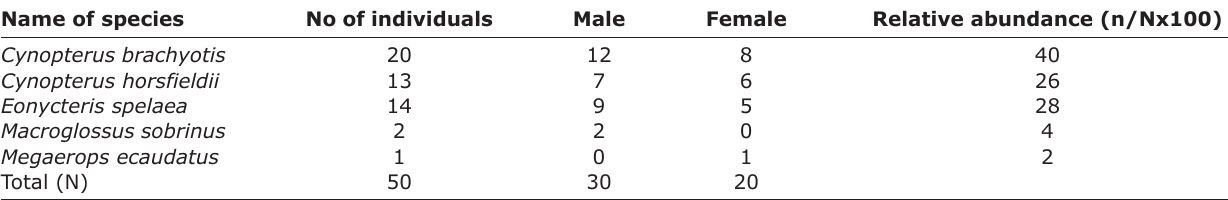
Table-1: Bat species. captured during the period of May- July 2017 at Lenggong Deer Farm. Name of species